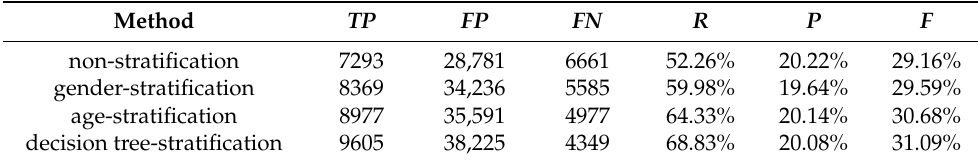
Table 4. Comparison of detection results of different stratification